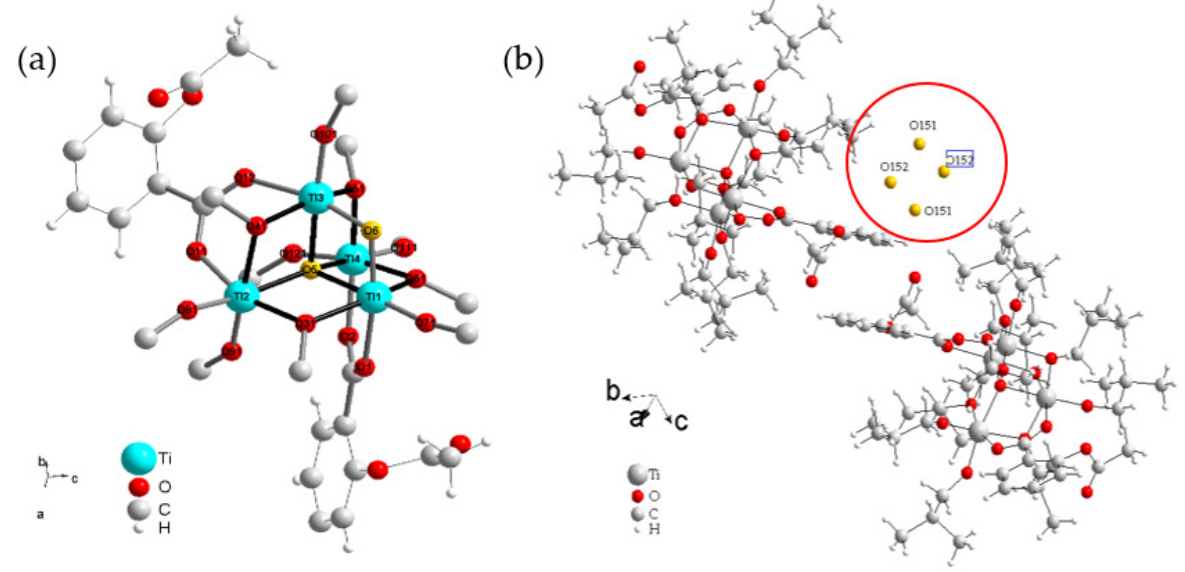
Figure 1. ( a ) Ti 4 O 2 core of [Ti 4 O 2 (asp) 2 (Bu i O) 10 ] · H 2 O ( 1 ) with labeled titanium and oxygen atoms. For clarity of the picture, all hydrogen atoms and the most of carbon atoms are omitted. Oxygen atoms from oxo bridges are given in yellow, from carboxylate anions in orange, from Bu i O − anions in red. ( b ) Positions of water molecules oxygen atoms (yellow and circled) presented in the crystal lattice of ( 1 ).